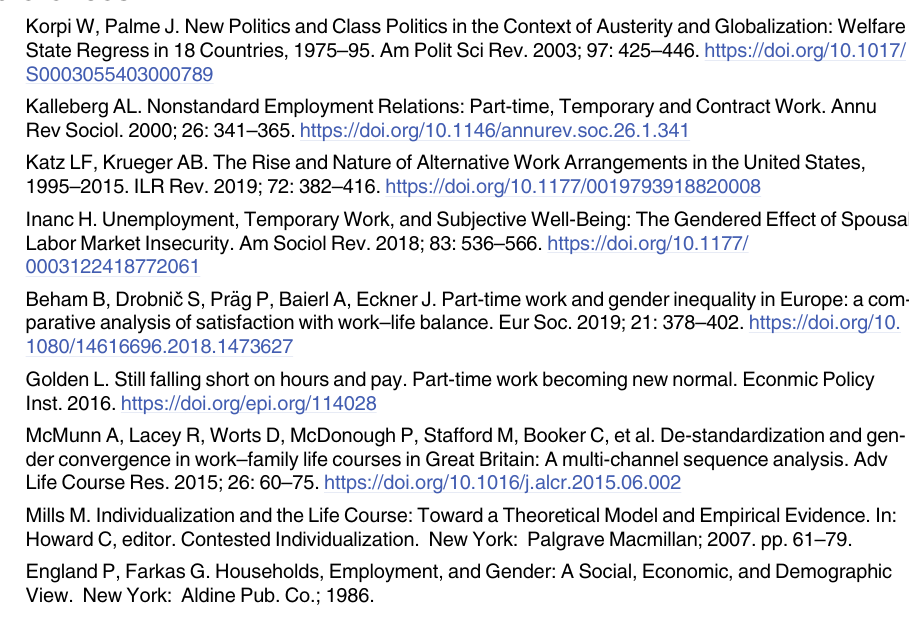
S5 Table. Full-interaction models for German respondents w/ children in household as moderator. S6 Table. Full-interaction models for Dutch respondents w/ children in household as mod- erator. S7 Table. Full-interaction models w/ respondent’s current employment status as modera- tor. S8 Table. Full-interaction models w/ respondent’s current job satisfaction as